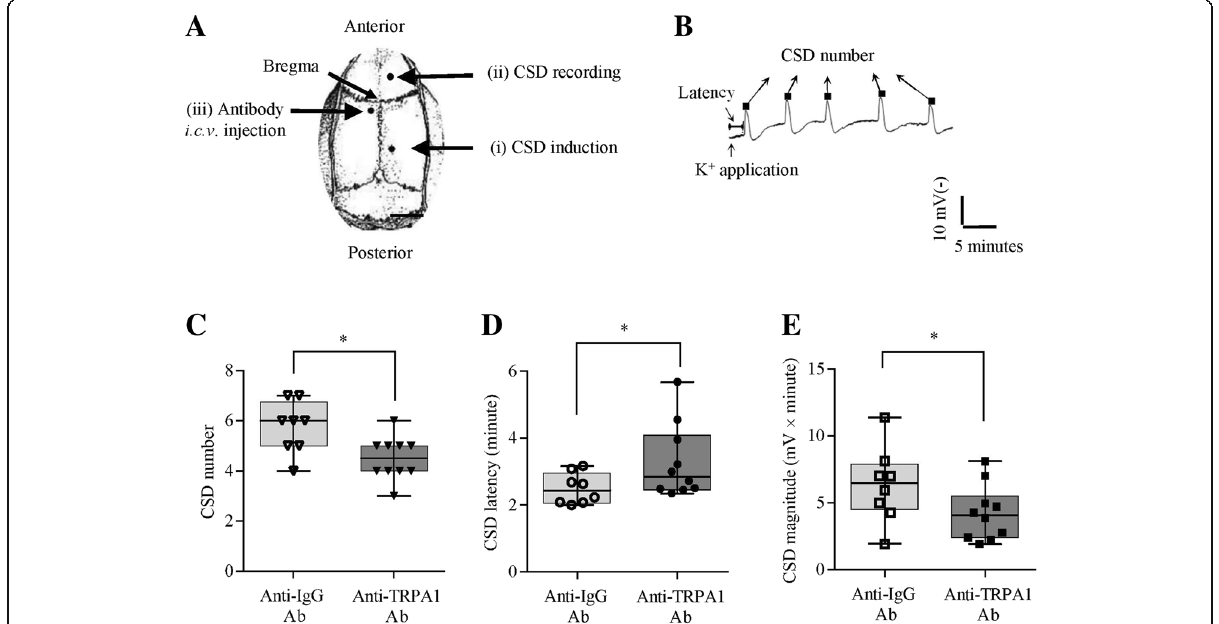
Fig. 3 Effects of the anti-TRPA1 antibody, perfused into the contralateral ventricle, on cortical susceptibility to CSD in rats. a CSD was induced by topical application of 2 M KCl for 30 min onto cerebral cortex with dura intact via the posterior burr hole on the right parietal bone. The ipsilateral anterior hole was used for CSD recording. The anti-TRPA1 antibody (i, n = 10) or anti-IgG antibody (ii, n = 8) was perfused through a cannula implanted in the contralateral ventricle ( i.c.v ) at 4 days prior to CSD induction. In the sham group (iii), the anti-IgG antibody was i.c.v perfused in the absence of KCl application as the control ( n = 7). The whole ipsilateral cerebral cortical tissue was subsequently used for detecting MDA level immediately after the in vivo experiment. b A representative trace showing CSD propagation wave after i.c.v perfusion of the anti-IgG antibody. CSD number, latency (minute) and magnitude (area under the curve of each CSD wave, mV × minute) were used for quantifying the excitation phase of CSD. The effects of the anti-TRPA1 antibody at 0.8 μ g on CSD number are shown in panel ( c ), latency in panel ( d ) and magnitude in panel ( e ). All the values shown are median (range). * p < 0.05, Mann-Whitney U test with one-tailed calculation was used for comparison of